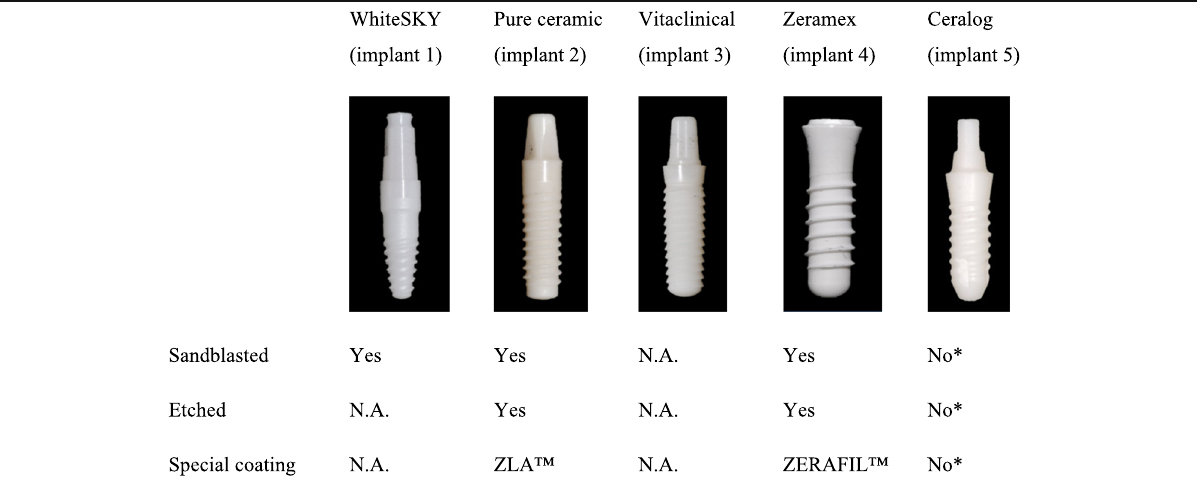
Table 1 Five commercially available ceramic implants and surface characteristics